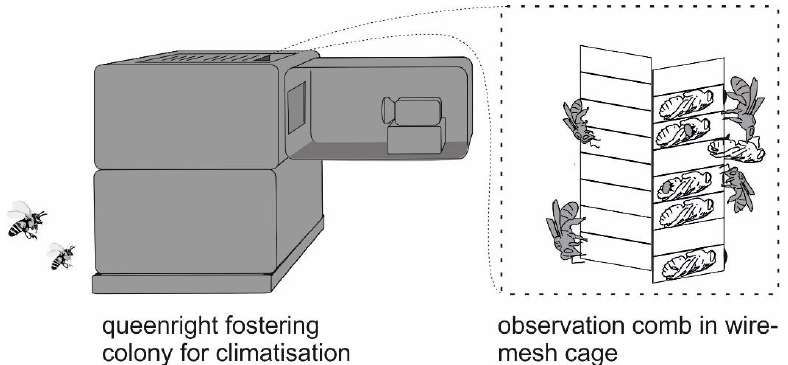
Figure 1. Experimental setup for the observation of hygienic behavior. Insects 2020 , 11 , x FOR PEER REVIEW